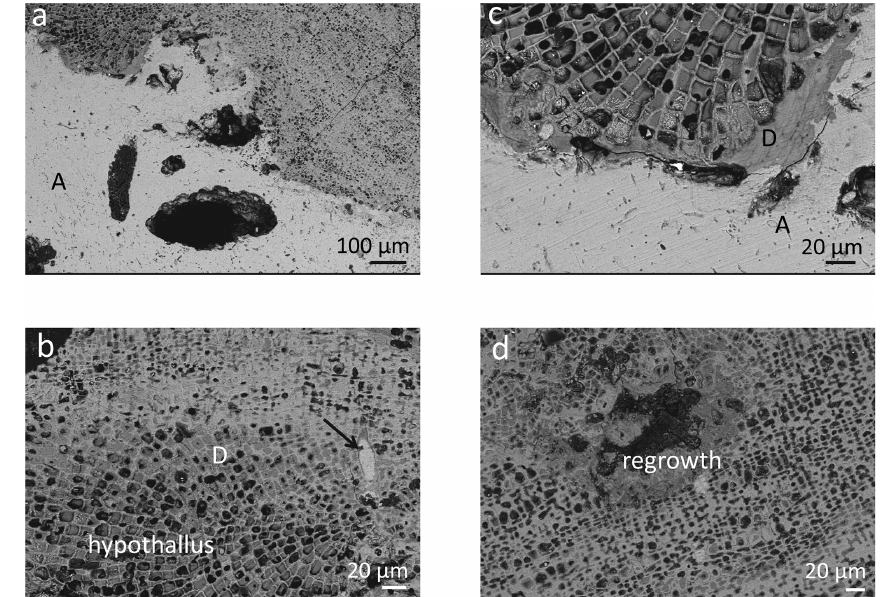
Figure 8. SEM (BSE) of varied mineral fabrics in CCA. (a) Alteration of base of CCA crust by bacteria to aragonite (Diaz-Pulido et al., 2014), remnant CCA cells are visible in the aragonite (A) confirming it was CCA crust and not coral substrate. (b) Hypothallus cells grow parallel to substrate then grow vertically and are in-filled with dolomite (D). In-fill of micro-borer trace by aragonite and dolomite rim (arrow). (c) Band of dolomite between aragonite alteration and undamaged cells. (d) Damaged crust has been in-filled with new cell growth rich in dolomite. Scale bars: (a) = 100 microns, (b, c) and (d) = 20